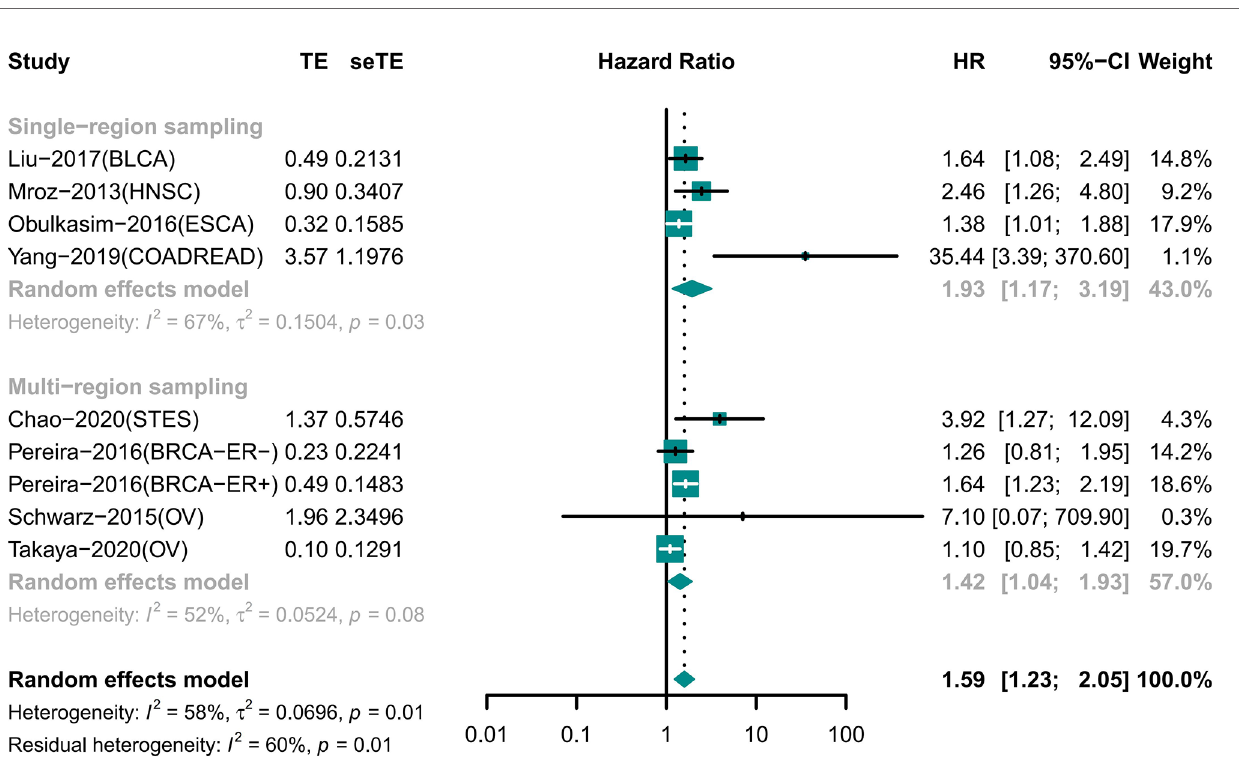
FIGURE 4 | Forest plot of intratumor heterogeneity (ITH) with prognosis in diverse sampling